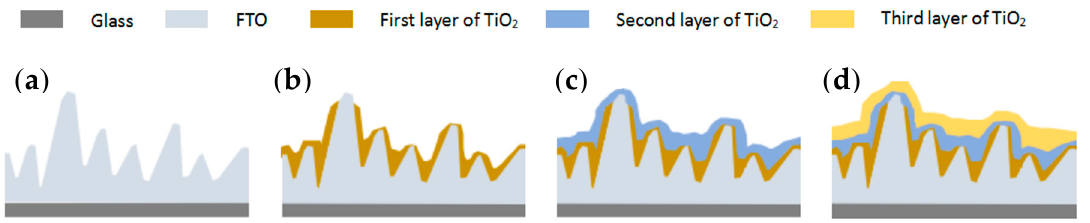
Figure 4. Schematic diagram of multiple layers of TiO 2 on rough FTO substrate. ( a ): rough FTO; ( b ): 1 layer of TiO 2 on the FTO; ( c ): 2 layer of TiO 2 on the FTO; ( d ): 3 layer of TiO 2 on the FTO.